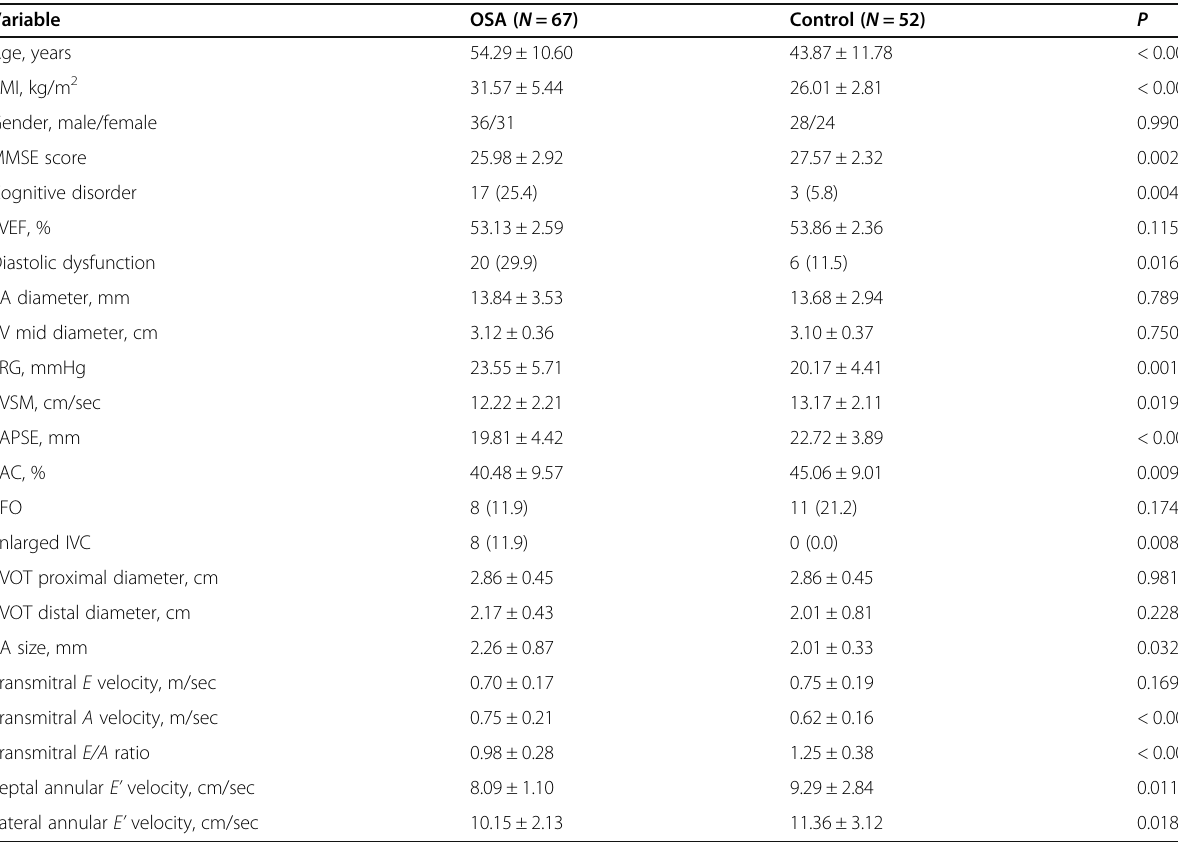
Table 1 Comparing the patients with and without obstructive sleep apnea (OSA) a,